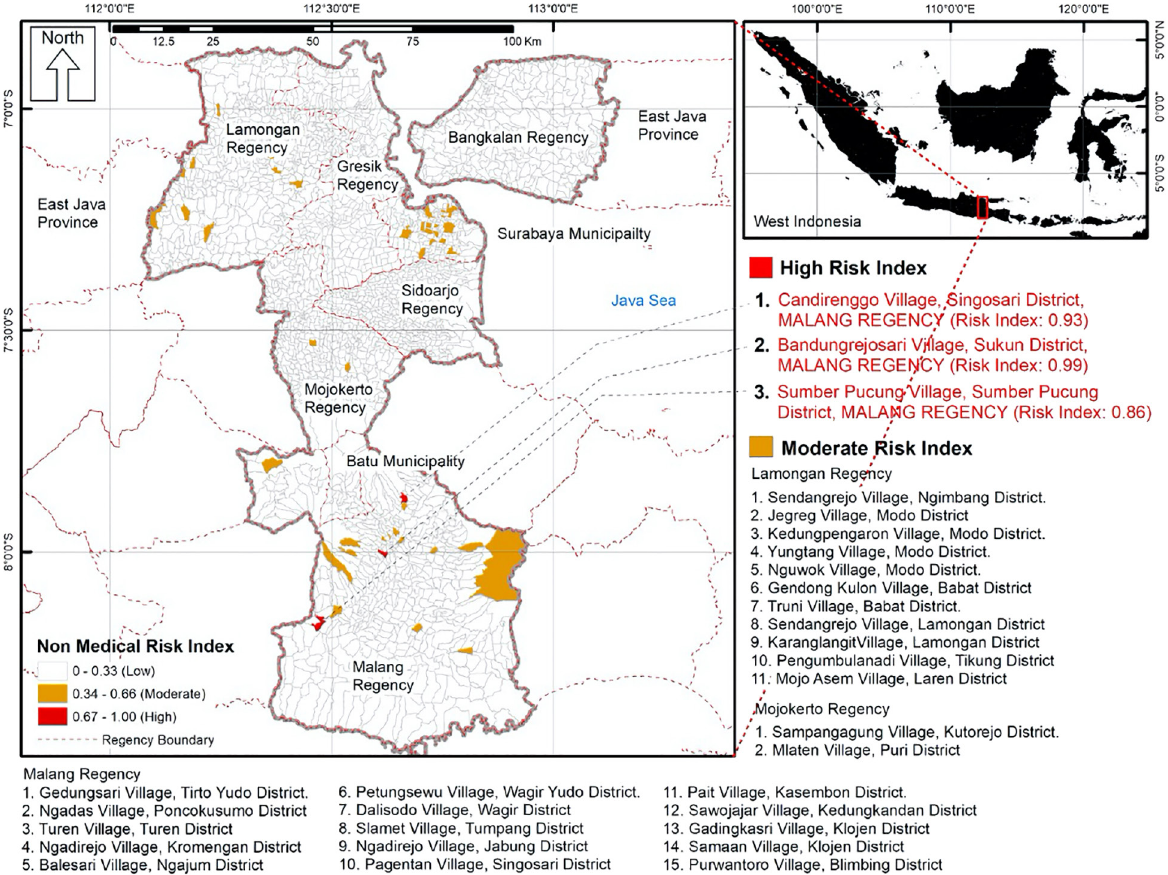
Fig. 12. Non-medical risk index in Greater